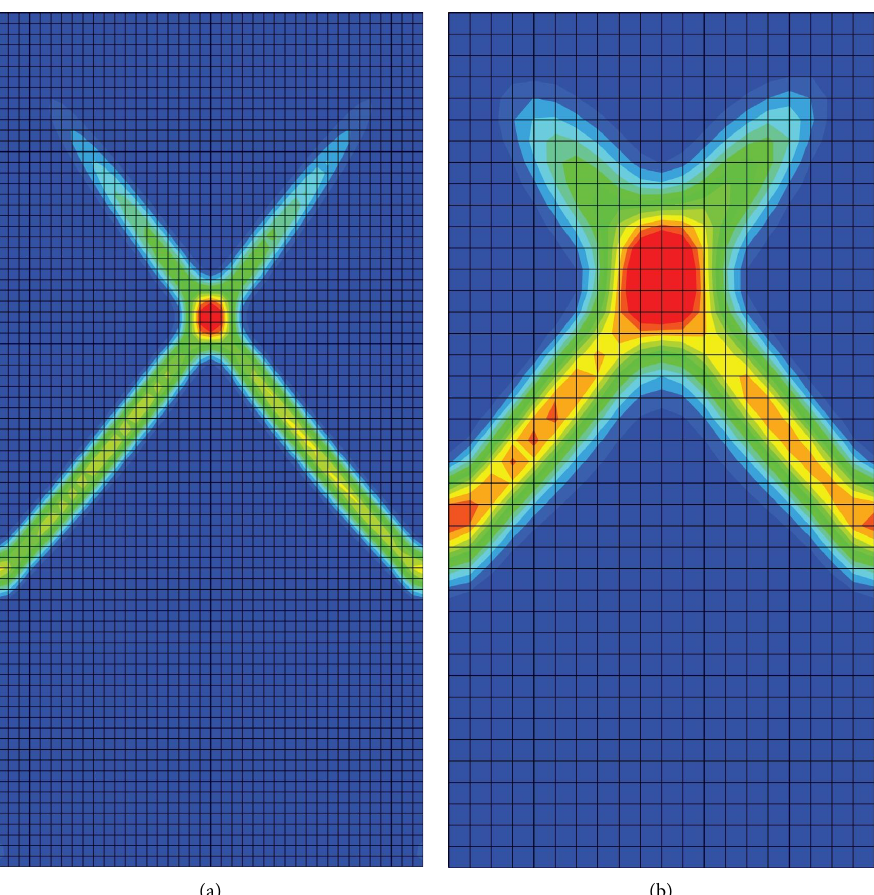
Figure 5: Distributions of the shear band under diferent mesh densities using FEM: (a) fne mesh (the element size is 1 mm); (b) coarse mesh (the element size is 2mm).